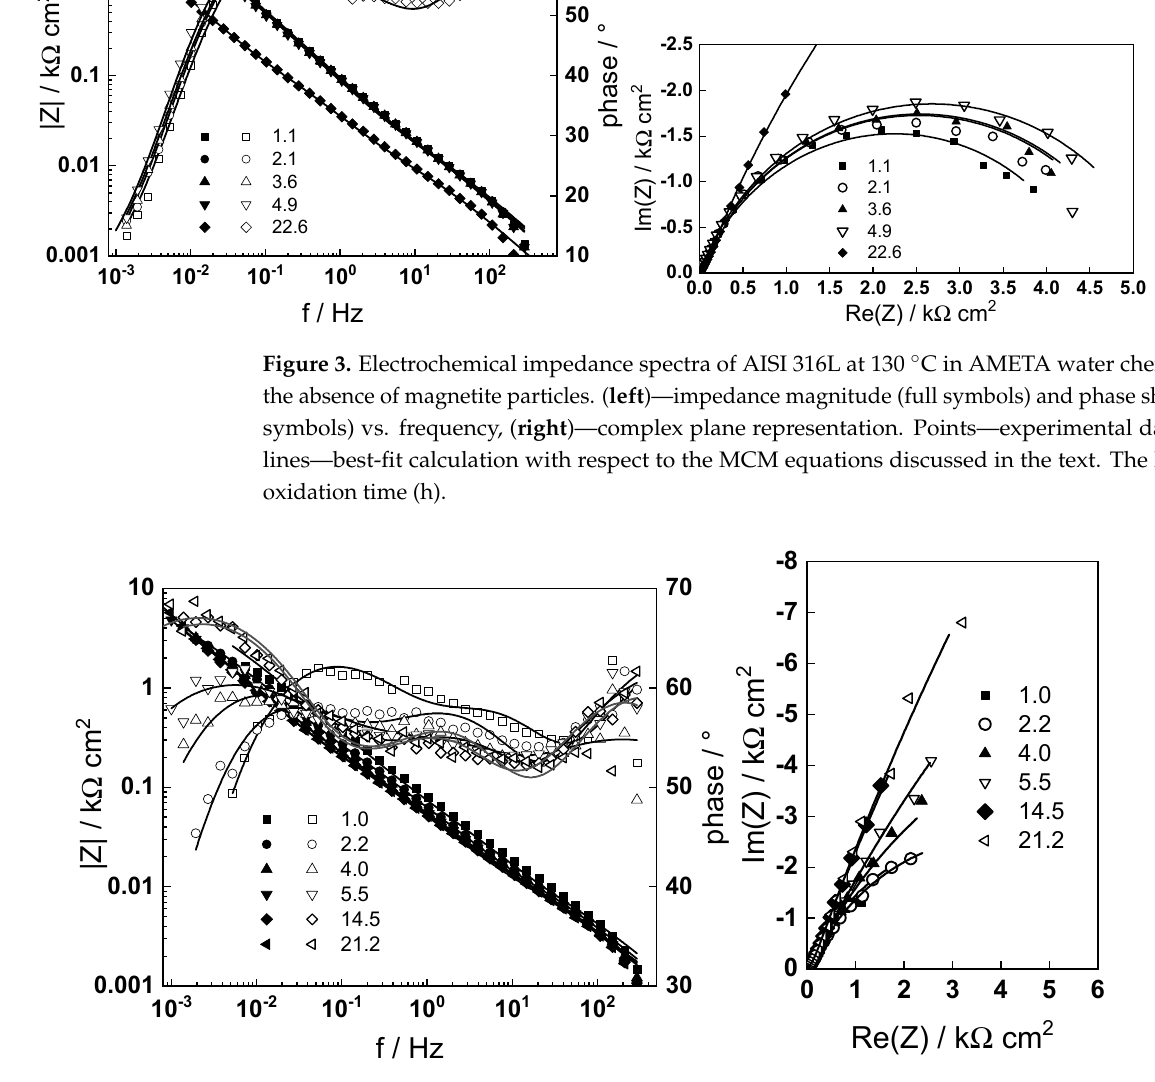
Figure 4. Electrochemical impedance spectra of AISI 316L at 130 ° С in AMETA water chemistry in the presence of 1.0 mg/dm − 3 magnetite particles. ( left )—impedance magnitude (full symbols) and phase shift (open symbols) vs. frequency, ( right )—complex plane representation. Points—experi- mental data, solid lines—best-fit calculation with respect to the MCM equations discussed in the text. The legend is oxidation time (h).